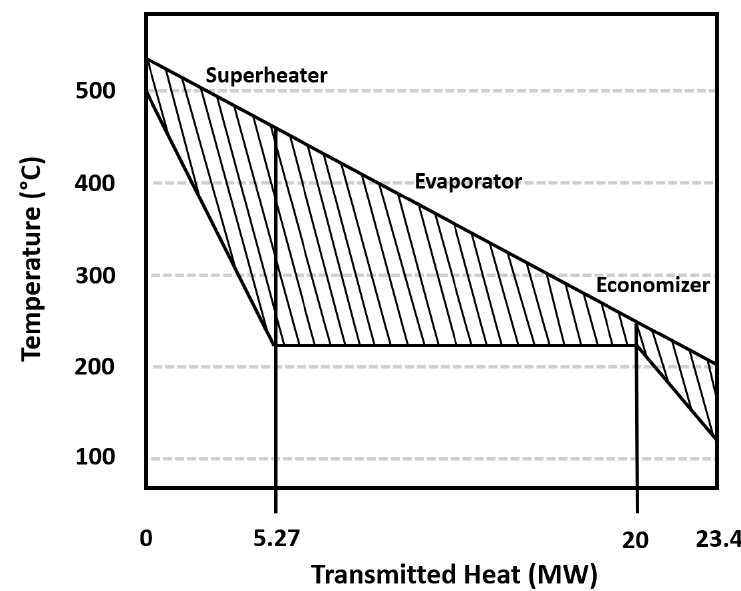
Figure 4. Q-T diagram for HRSG.